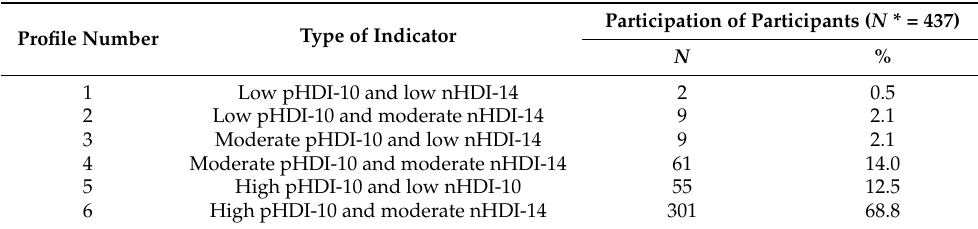
Table 1. Diet quality index profiles with the proportion of study participants characterized by a given